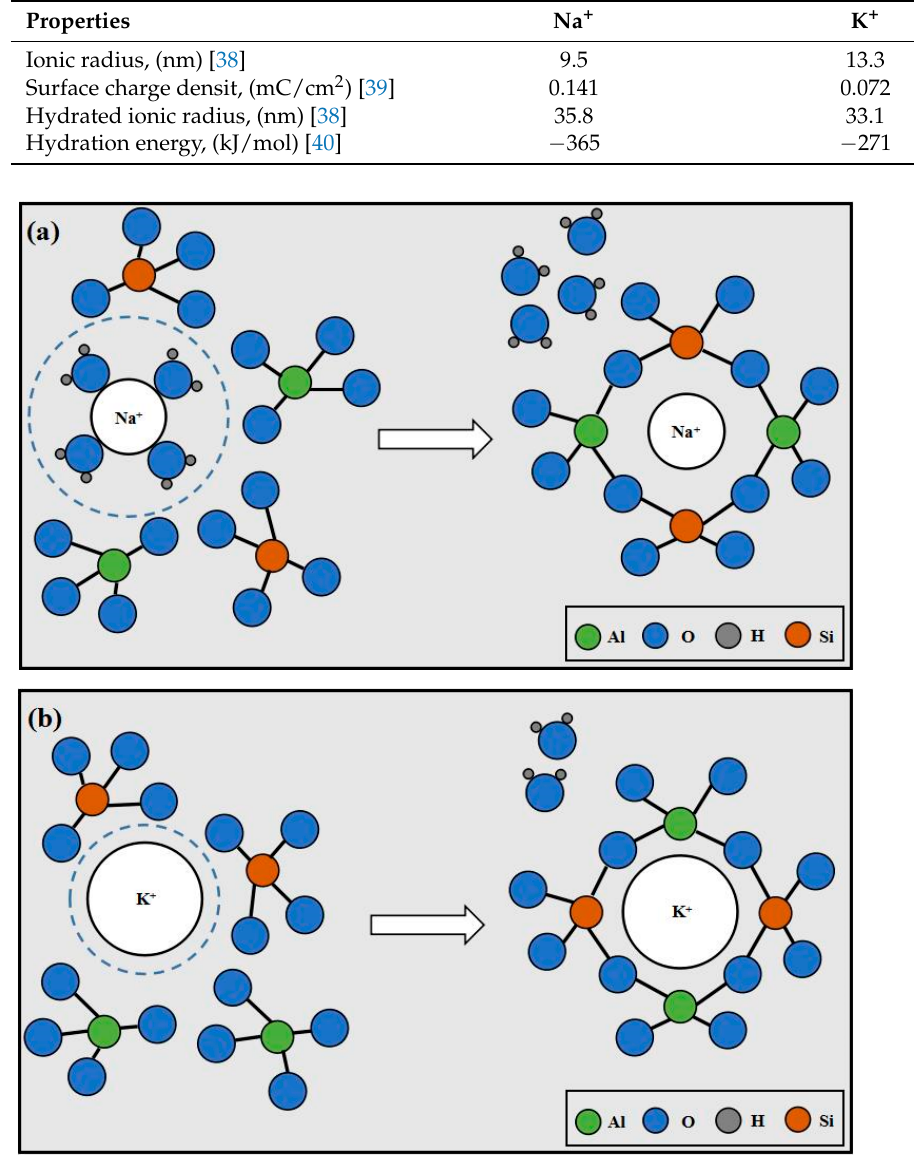
Figure 8. The schematic diagram of the polymerization of AAS incorporated with K + and Na + . The ionic radius of K + (13.3 nm) is bigger than that of Na + (9.5 nm), but the hydrated ionic radius of K + (33.1 nm) is smaller than that of Na + (35.8 nm), as shown in Table 3. This indicates that the polymerization abilities of K + and Na + are different. The dipole moment of the water molecule increases as the temperature of the solution drops, and the affinity between water molecules and ions in the solution is enhanced. This leads to an increased combining ratio between alkali metal cation R + and water molecules. As a result, the num- ber of water molecules adsorbed on R + will increase; that is, the thickness of the water film will increase [41].